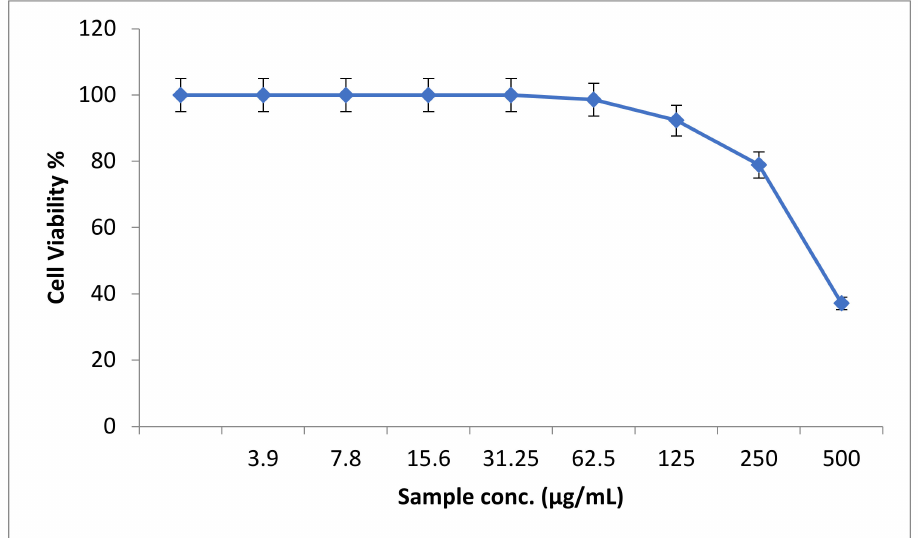
Figure 3. The percentage of normal mouse myoblast cells viability upon treatment with ZnO